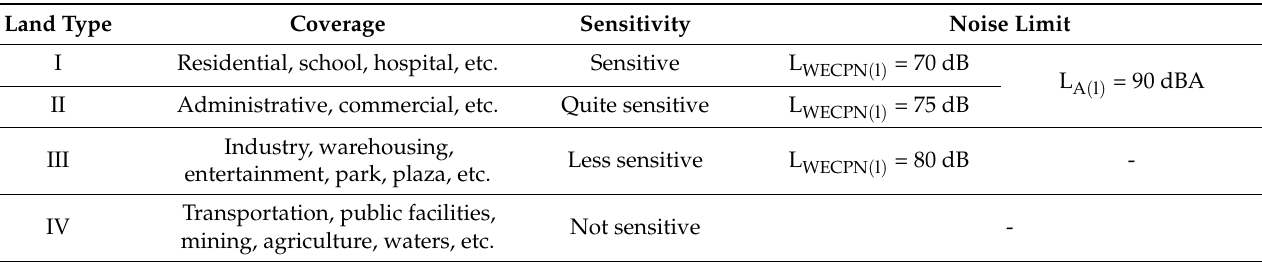
Table A2. Noise limits and sensitivity of different land types around the airport [41]. L WECPN ( l ) is the noise limit of weighted equivalent continuous perceived noise level. L A ( l ) is the noise limit of A-weighted maximum sound pressure